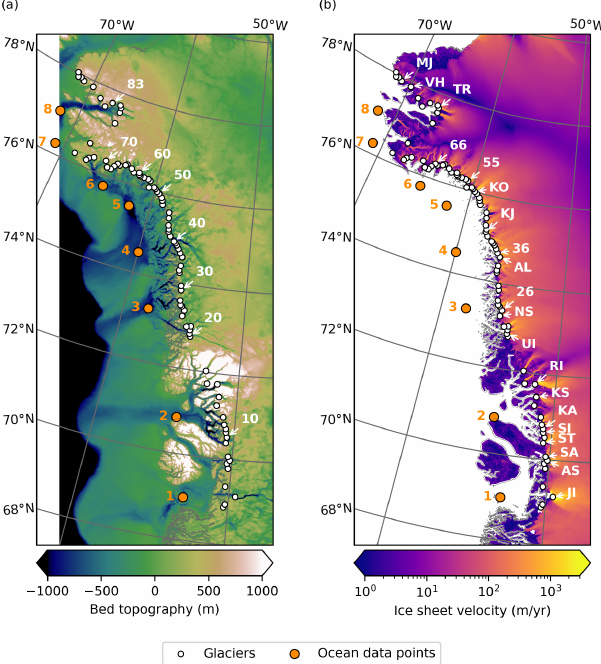
Figure 1. Map of study area, showing individual glacier locations (white) and points where ocean data were acquired (orange, num- bered). Glacier labels are (a) every 10th glacier, numbered, and (b) specific glaciers named in the paper, abbreviated as follows: Jakobshavn Isbræ (JI), Alianaatsup Sermia (AS), Sermeq Avan- narleq (SA), Store Gletsjer (ST), Sermilik Isbræ (SI), Kangilleq (KA), Kangerlussuup Sermia (KS), Rink Isbræ (RI), Upernavik Is- strøm (UI), Naajarsuit Sermiat (NS), unnamed glacier no. 26 (26), Alison Glacier (AL), unnamed glacier no. 36 (36), Kjer Gletsjer (KJ), Kong Oscar Gletsjer (KO), unnamed glacier no. 55 (55), un- named glacier no. 66 (66), Tracy Gletsjer (TR), Verhoeff Gletsjer (VH), and Morris Jesup Gletsjer (MJ). Basemaps are (a) bed topog- raphy from BedMachine Greenland V3 (Morlighem et al., 2017b, a) and (b) ice-sheet velocity from MEaSUREs GIMP (Joughin et al., 2016b,